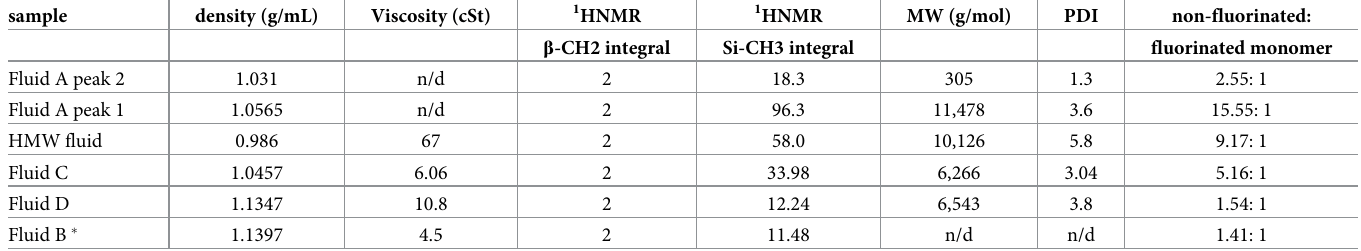
Table 3. Viscosity, density and other properties measured on fluorinated polysiloxanes. sample density